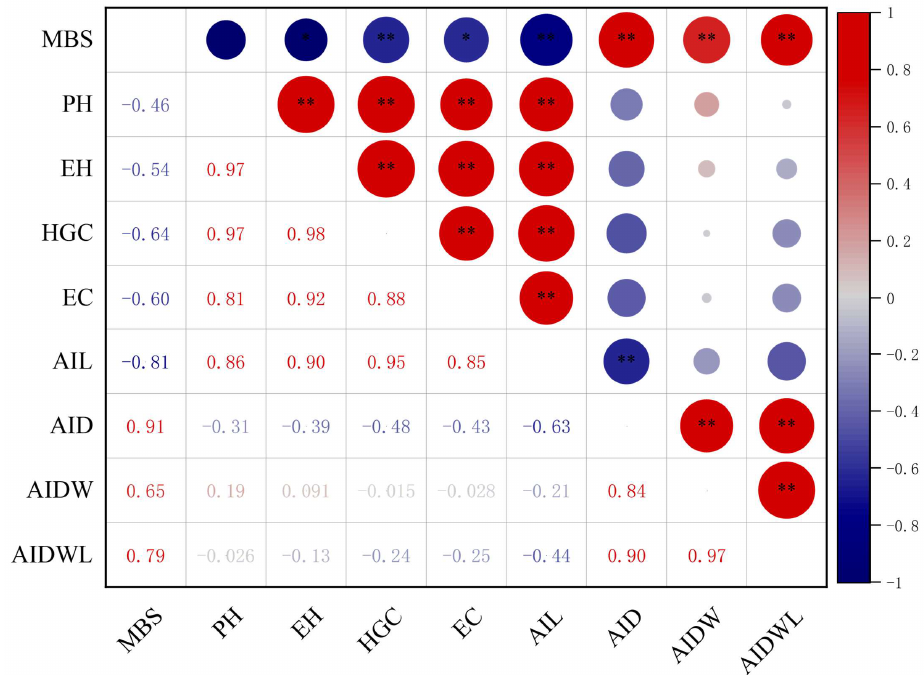
Figure 5. Correlation analysis. MBS: maximum bending strength, PH: plant height, EH: ear height; HCG: height of gravity center, EC: ear coefficient, AIL: average internode length, AID: average internode diameter, AIDW: average internode dry weight, AIRDWL: average of internode ratio of dry weight to length (average of internode dry weight per unit). * and ** indicate significant differences different at the 0.05 and 0.01 probability levels,